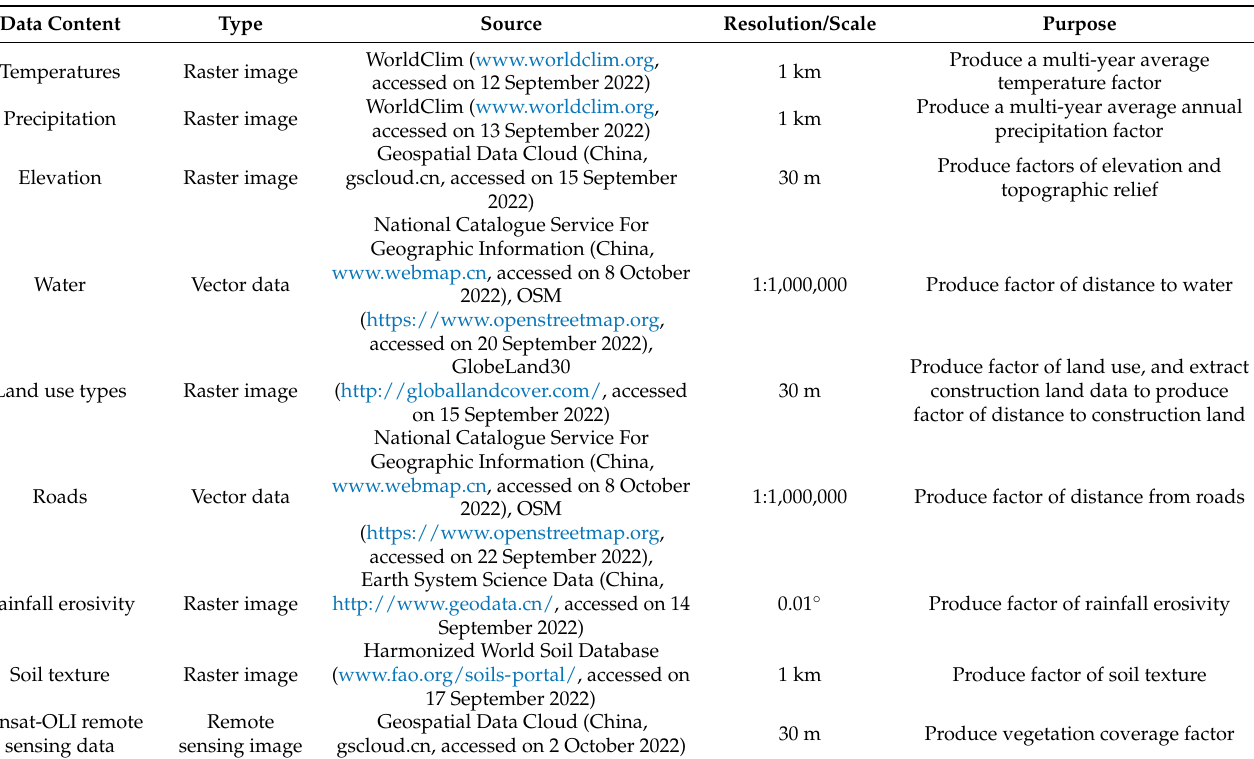
Table 1. Data sources and